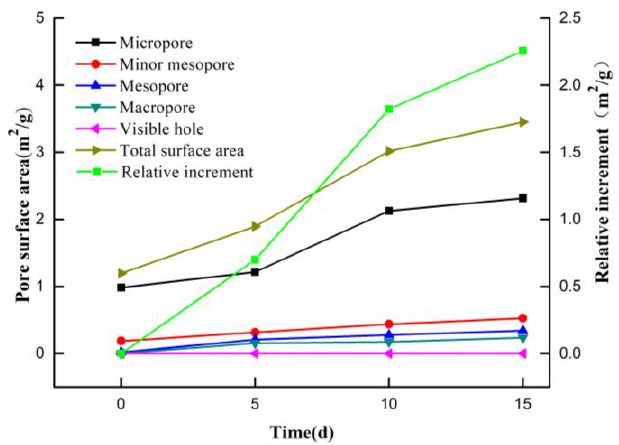
Figure 4. Curves of the change of pore surface area with soaking time.